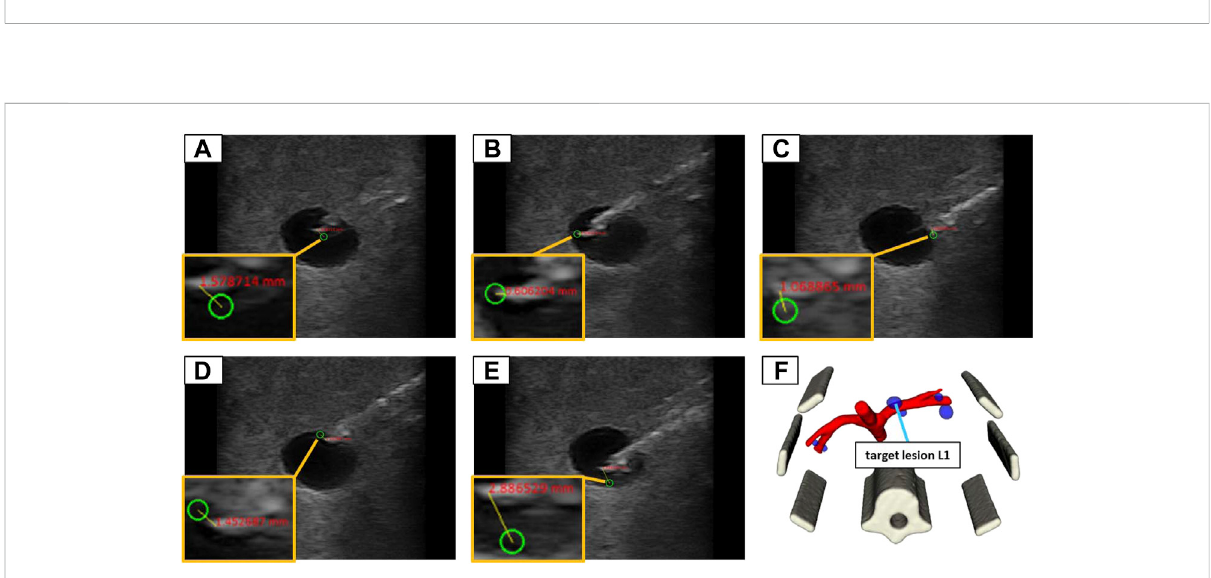
FIGURE 10 The 5 target positions inside of a lesion (L1) in the abdominal phantom for an in-plane needle positioning: (A) in the center; (B) left border; (C) right border; (D) top border; (E) bottom border; (F) illustrates the 3D model of the phantom to provide an overview where the lesion is located in 3D